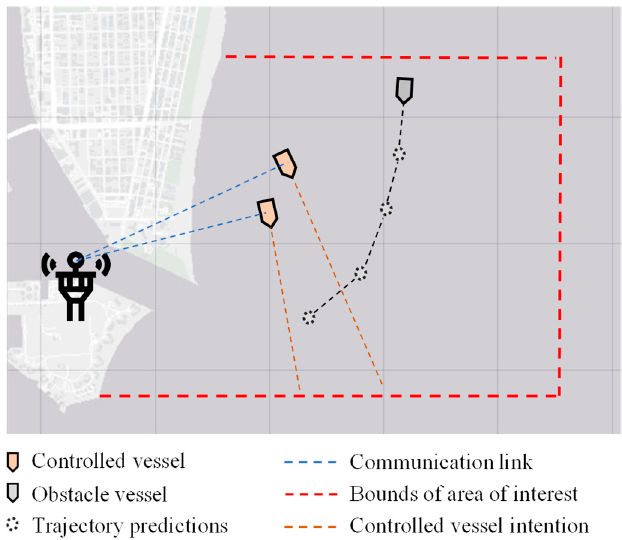
Figure 6. Communications within the proposed control framework.